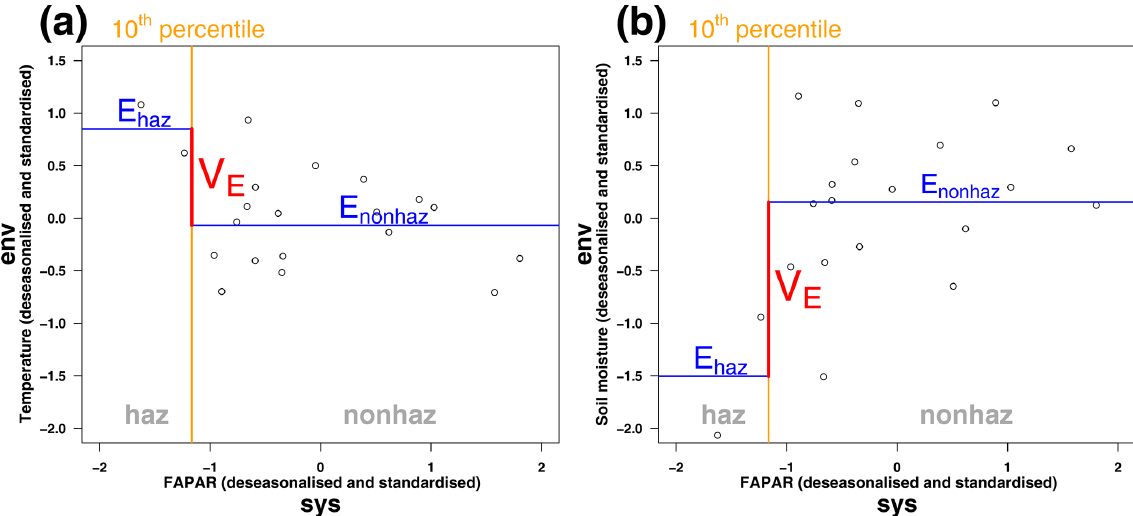
Figure 4. Schematic display of ecosystem vulnerability V E for an exemplary grid point for (a) temperature and (b) soil moisture as environ- mental drivers for the month of